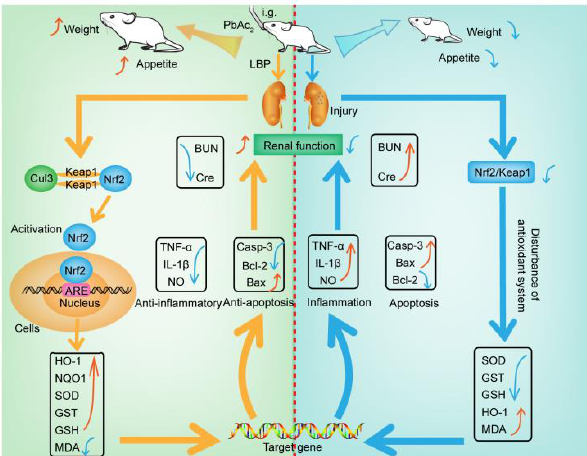
Figure 9. The mechanism of lead-induced renal injury in mice and the mechanism of LBP against lead-induced renal injury. Intragastric administration (i.g); Lead acetate (PbAc 2 ); Nitric oxide (NO); Tumor necrosis factor- α (TNF- α ); Malondialdehyde (MDA); Interleukin-1 β (IL-1 β ); Serum creatinine (Cre); Blood urea nitrogen (BUN); Caspase-3 (Casp-3); Superoxide dismutase (SOD); Glutathione S-transferase (GST); Glutathione (GSH); Cullin 3 (Cul3); Nuclear factor erythroid 2-related factor 2 (Nrf2); Kelch-like ECH-associated protein 1 (Keap1); Oxygenase-1 (HO-1); NAD(P)H dehydrogenase, quinone 1 (NQO1); Lycium barbarum polysaccharide (LBP); Antioxidant response element(ARE); Indicates up-regulation or recovery ( ↑ ); Indicates downregulation or inhibition ( ↓ )